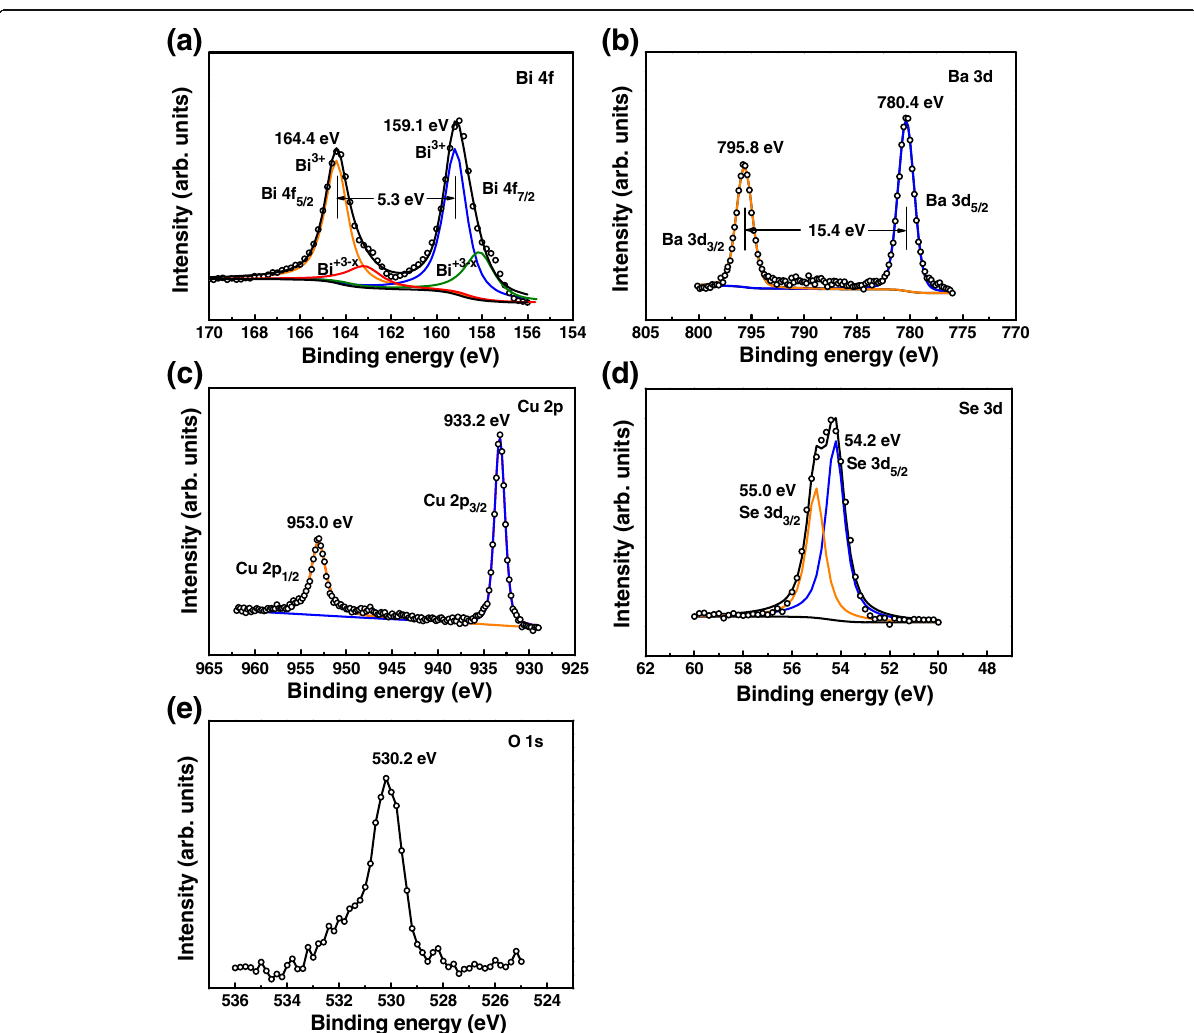
Fig. 3 XPS spectra of a Bi 4f, b Ba 3d, c Cu 2p, d Se 3d, and e O 1s in Bi 0.925 Ba 0.075 CuSeO thin